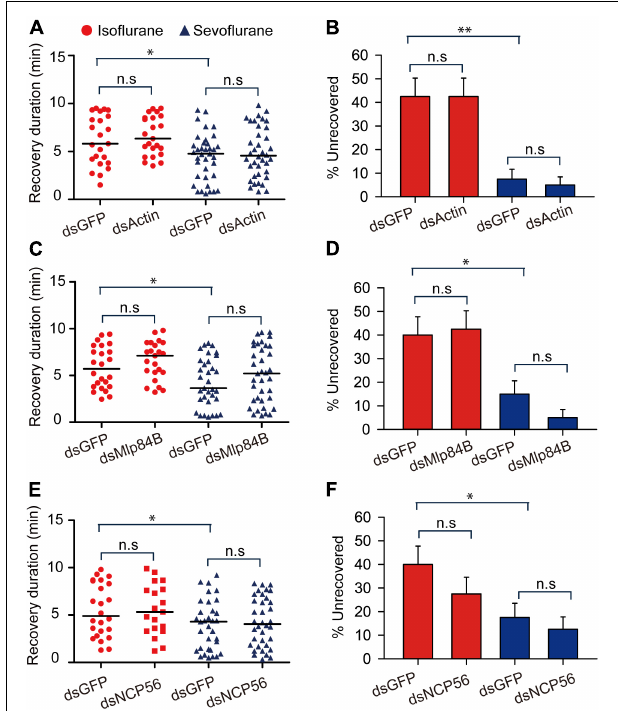
FIGURE 7 | Actin , Mlp84B , JAK and NCP56 do not affect recovery duration from isoflurane and sevoflurane anesthesia. (A) Actin RNAi knockdown does not respectively affect the duration of recovery from isoflurane and sevoflurane anesthesia ( n = 40 for each treatment). (B) Actin RNAi knockdown does not affect the percentage of unrecovered locusts with isoflurane and sevoflurane anesthesia ( n = 40 for each treatment). (C) The effects of Mlp84B RNAi knockdown on the recovery duration from isoflurane and sevoflurane anesthesia ( n = 40 for each treatment). (D) Mlp84B RNAi knockdown does not affect the percentage of unrecovered locusts with isoflurane and sevoflurane anesthesia ( n = 40 for each treatment). (E) NCP56 RNAi knockdown does not affect the recovery duration from isoflurane and sevoflurane anesthesia ( n = 40 for each treatment). (F) NCP56 RNAi knockdown does not affect the percentage of unrecovered locusts with isoflurane and sevoflurane anesthesia ( n = 40 for each treatment). Mann–Whitney U test is used for analyzing differential recovery duration from isoflurane and sevoflurane anesthesia, and G-test for independence is used for analyzing the effects of RNAi knockdown on the percentage of uncovered locusts within10 min after discontinuing anesthesia. n.s P > 0.05, ∗∗ P < 0.01, ∗ P < 0.05. Abbreviations: Mlp84B, Myosin-like protein 84B; NCP56, nymph cuticle protein